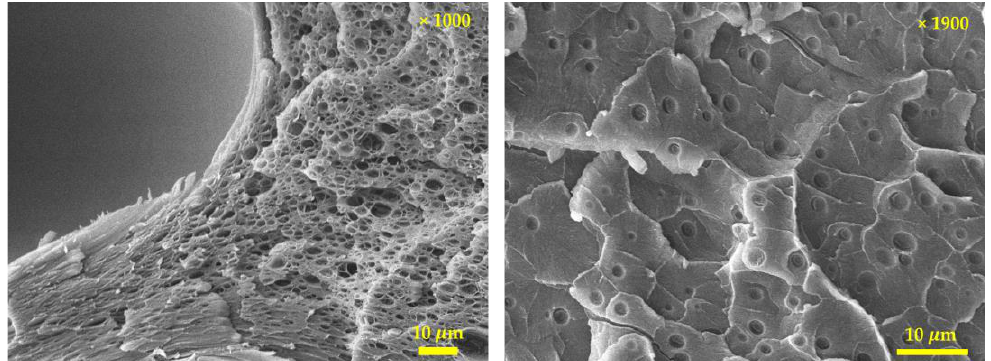
Figure 9. SEM images of specimen after solid-state surface patterning at 180 min of saturation.